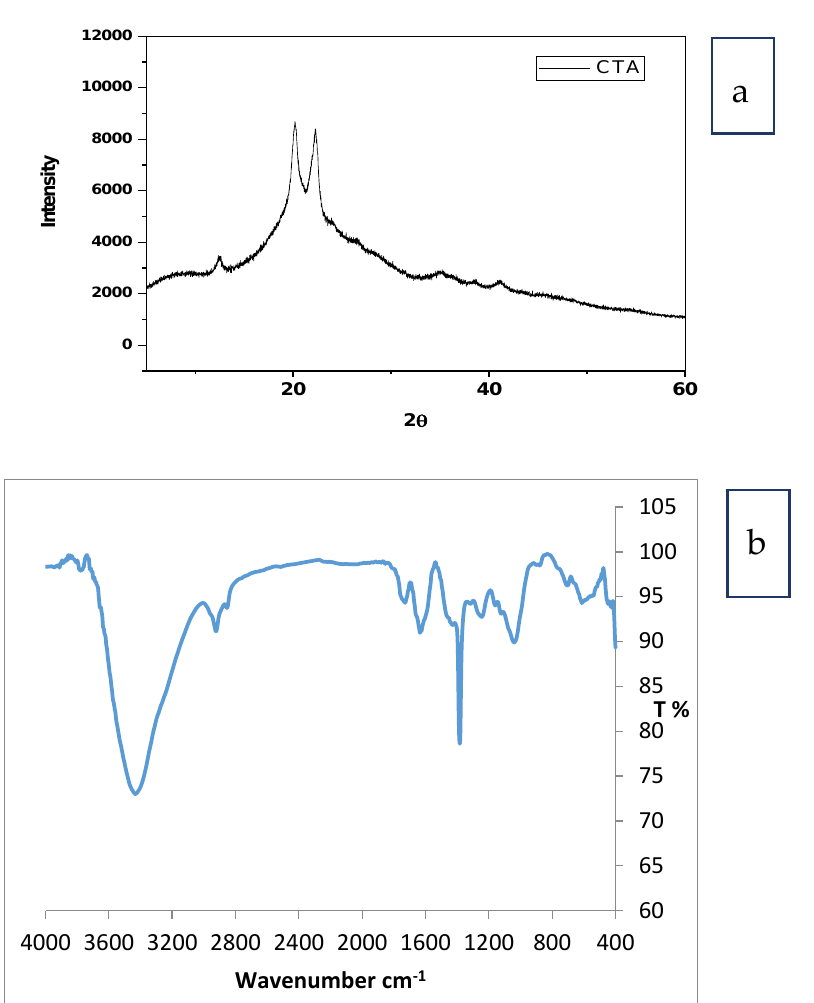
Figure 2 . ( a ) XRD and ( b ) FTIR spectrum for cellulose (triacetate) prepared from palm fronds. Figure 2b shows the FTIR spectrum for cellulose triacetate. The peak at 1730 cm − 1 was characteristic to wide CO band for bonding acetyl groups. A small band at 1369 cm − 1 was assigned to C – H bond in OCOCH 3 group and the band detected at 1240 cm − 1 was assigned